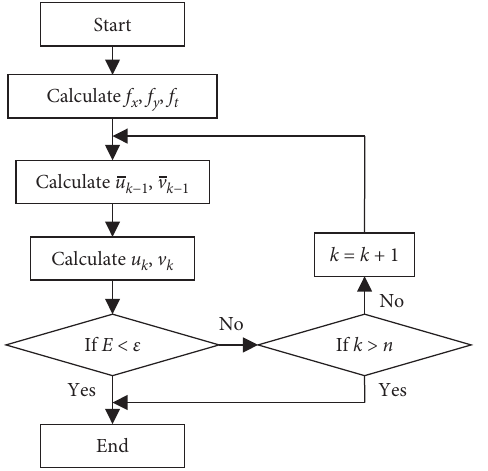
Figure 2: Flowchart of the HS